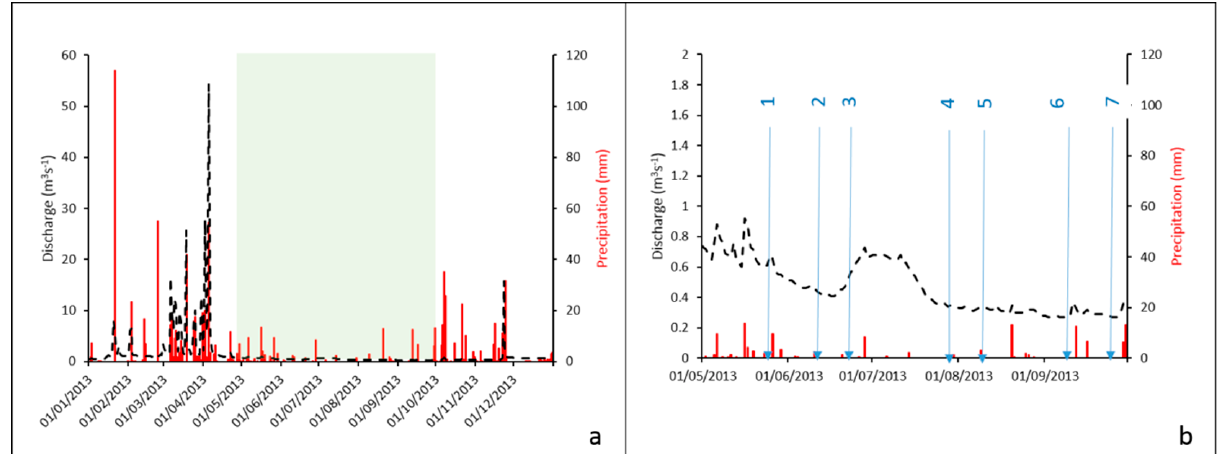
Figure 4. ( a ) Daily discharges (dashed black line) and precipitations (red line) detected in R1 (here, we recall that R1 is located in the same place of section S4) from 1 January 2013 to 31 December 2013. ( b ) Detail of the period from 1 May 2013 to 30 September 2013 in which the seven salt-diluted solution slug injection campaigns were carried out (blue arrows).